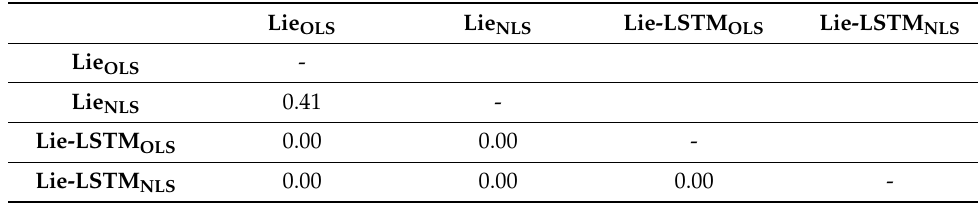
Table 7. p -values for the Wilcoxon signed-rank